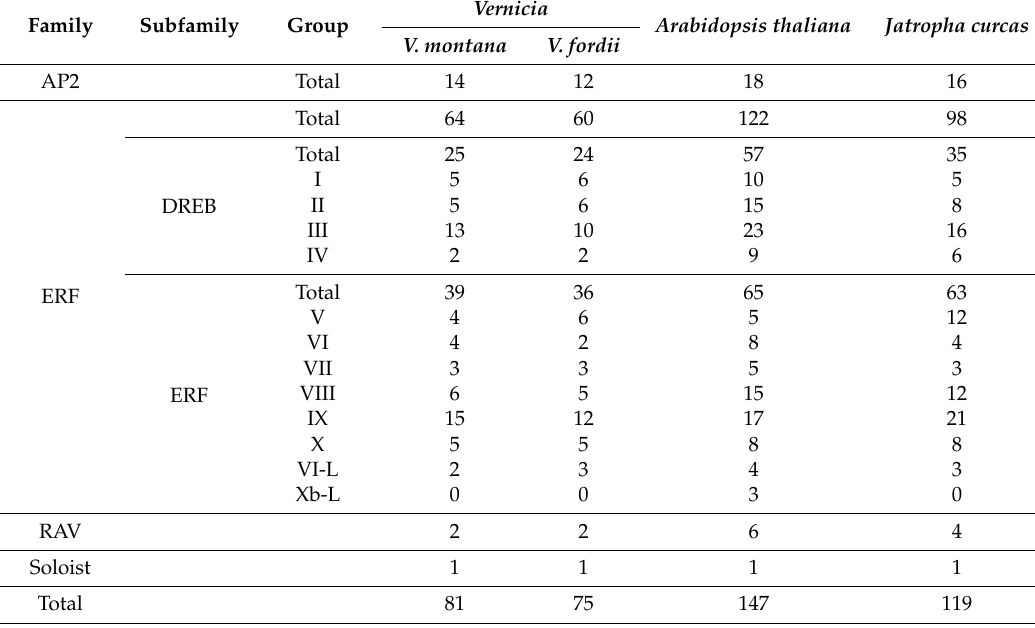
Table 1. Summary of the classification and number of genes in the APETALA2/ethylene-responsive element binding factor (AP2/ERF) superfamily in Vernicia montana , Vernicia fordii , Arabidopsis thaliana and physic